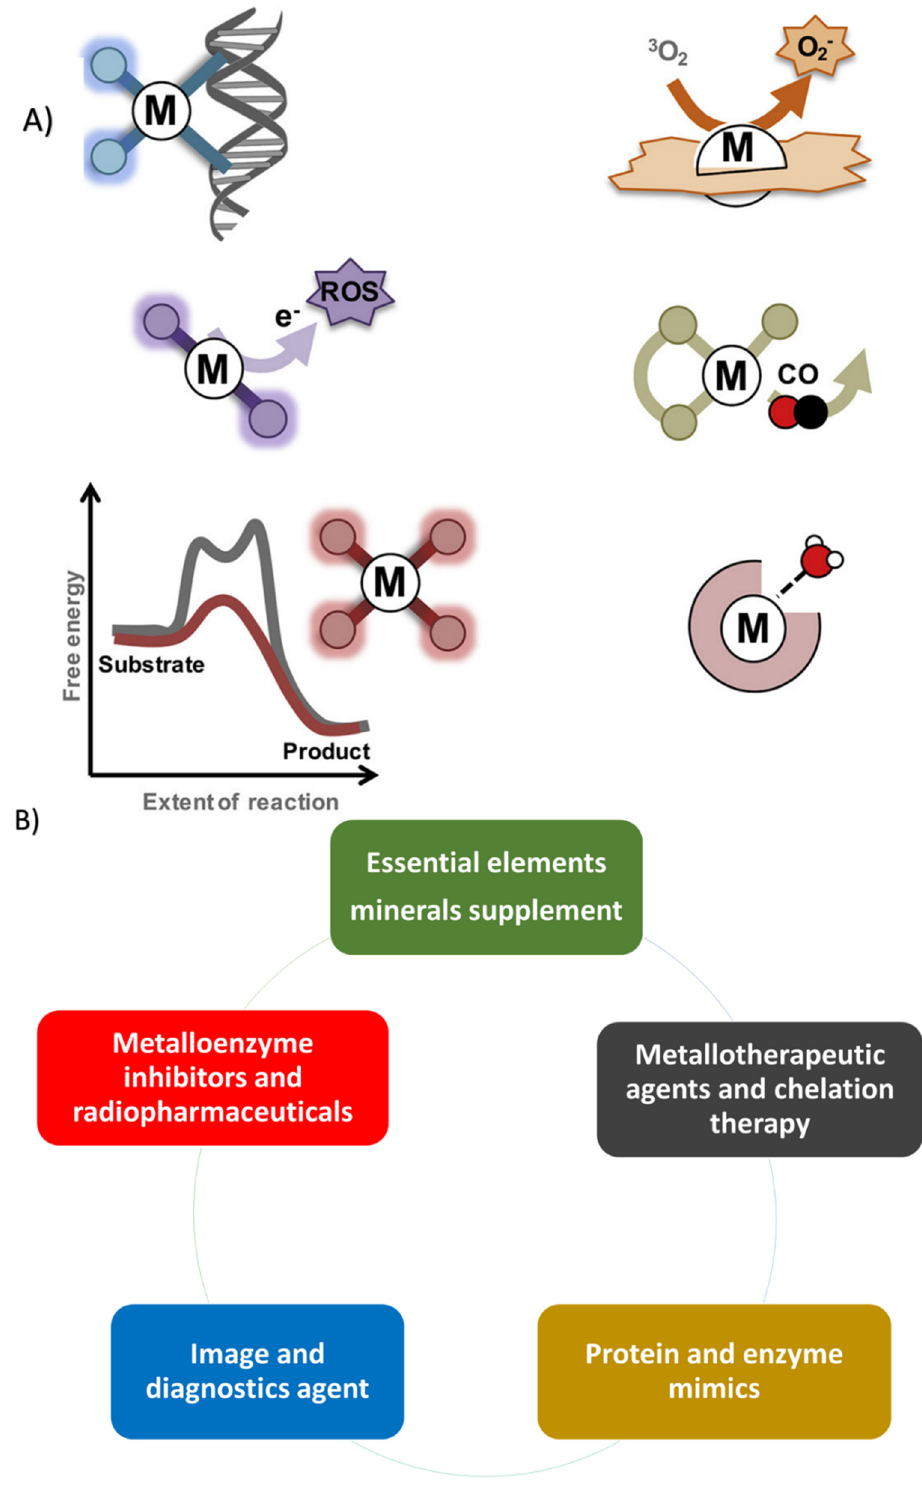
Figure 1. ( A ) Mechanism of action of metal-based drugs; ( B ) schematic representation of different metals used in medicines. Adapted from [21]. Reproduced with permission from Elsevier.